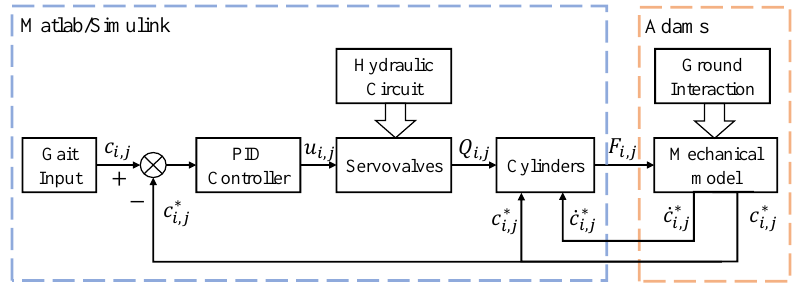
Figure 13. Overview of the virtual prototype.